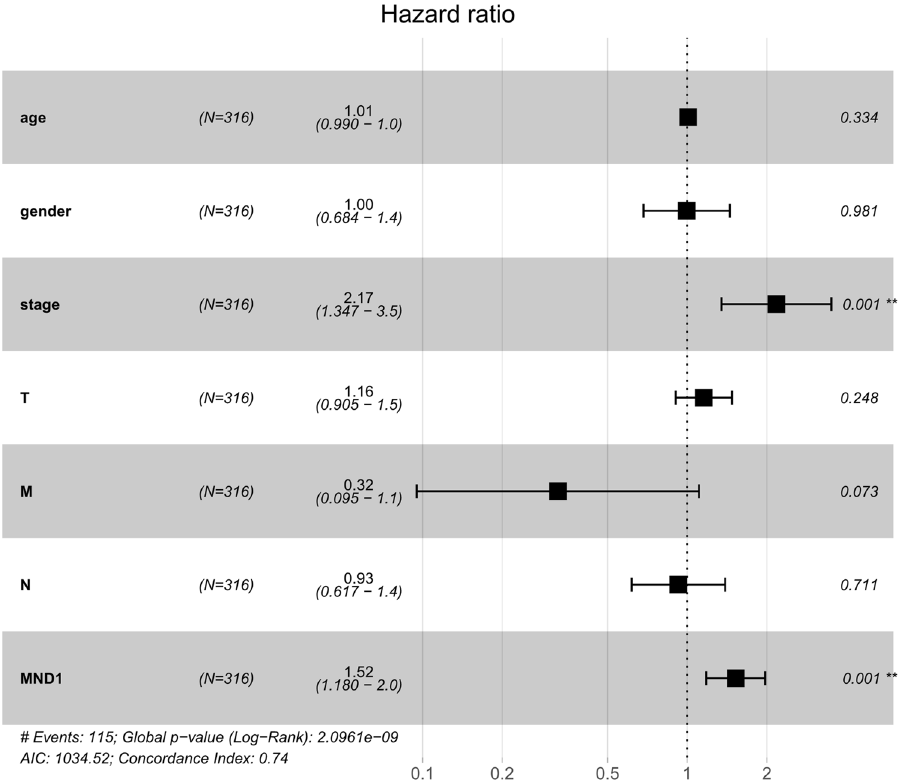
Figure 3. Forest plot from univariate Cox regression analysis of the associations of MND1 expression with clinic-pathological